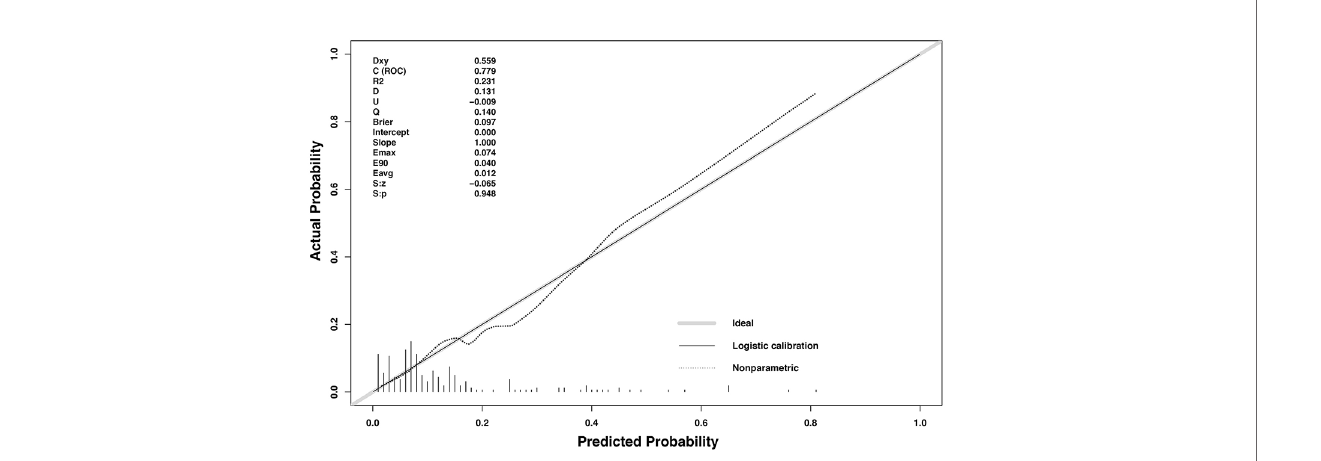
FIGURE 6 | The calibration curves for predicting regrowth in patients with benign thyroid nodules after RFA. The x-axis represents the nomogram predicted probability and the y-axis represents the actual probability. The calibration curves were close to the 45° line. The diagonal dashed line indicates ideal prediction by a perfect model, and the solid line represents the predictive power of the nomogram. The closer the solid line is to the dotted line, the better is the predictive power of the